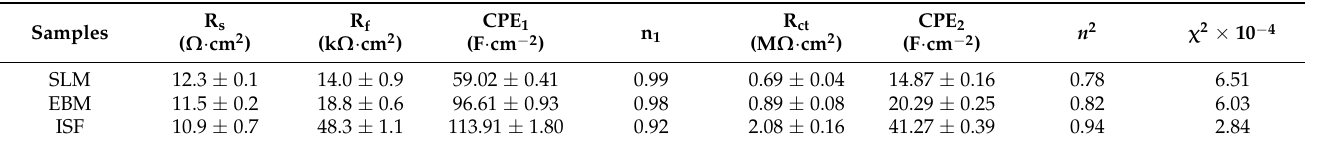
Table 2. Fitting parameters of EIS for the SLM- and EBM-manufactured and ISF Ti-6Al-4V alloy samples in the 3.5 wt.% NaCl solution.